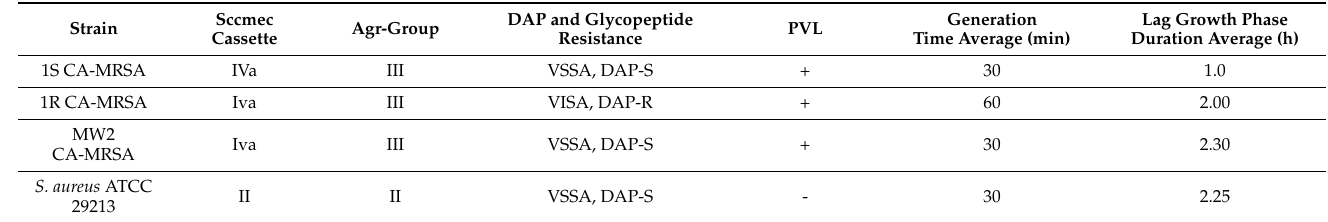
Table 1. Generation times and lag growth phase kinetics.